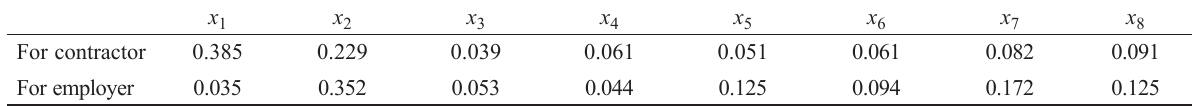
Table 3. Criteria